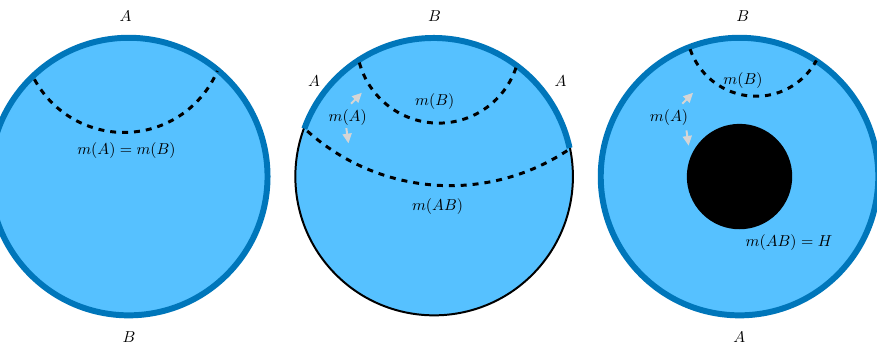
I ( A : B ) is suboptimal to the program (2.8). 2